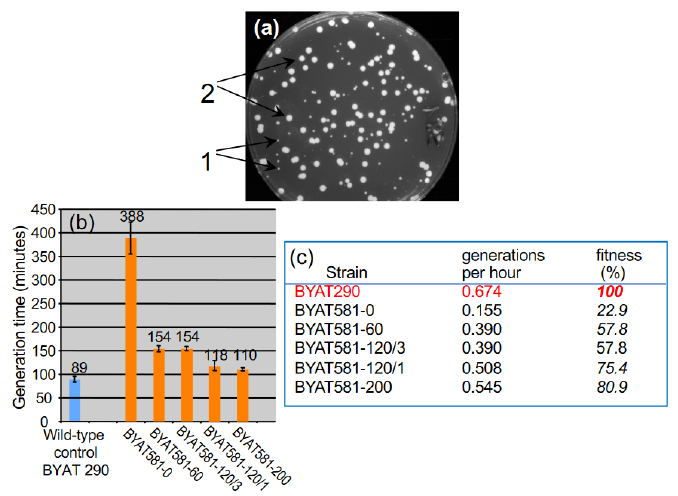
Figure 1. Isolation and growth characteristics of evolved mutants. ( a ): apparition of evolved mutants during the evolu- tionary trajectory of BYAT581 (Culture n°8, see Table 1). Note the clearcut difference between slow-growing colonies (1) similar to the initial BYAT581 strain, and faster-growing colonies (2) corresponding to the evolved mutants. ( b ): Colored bars: average generation times in minutes for each strain (see Section 2.3). Error bars represent 99% confidence limits (± 2.6 / √(n−1), where n is the number of subclones studied for each strain). ( c ): fitness expressed in % of the number of generations per hour of each strain relative to the wild-type strain BYAT290.